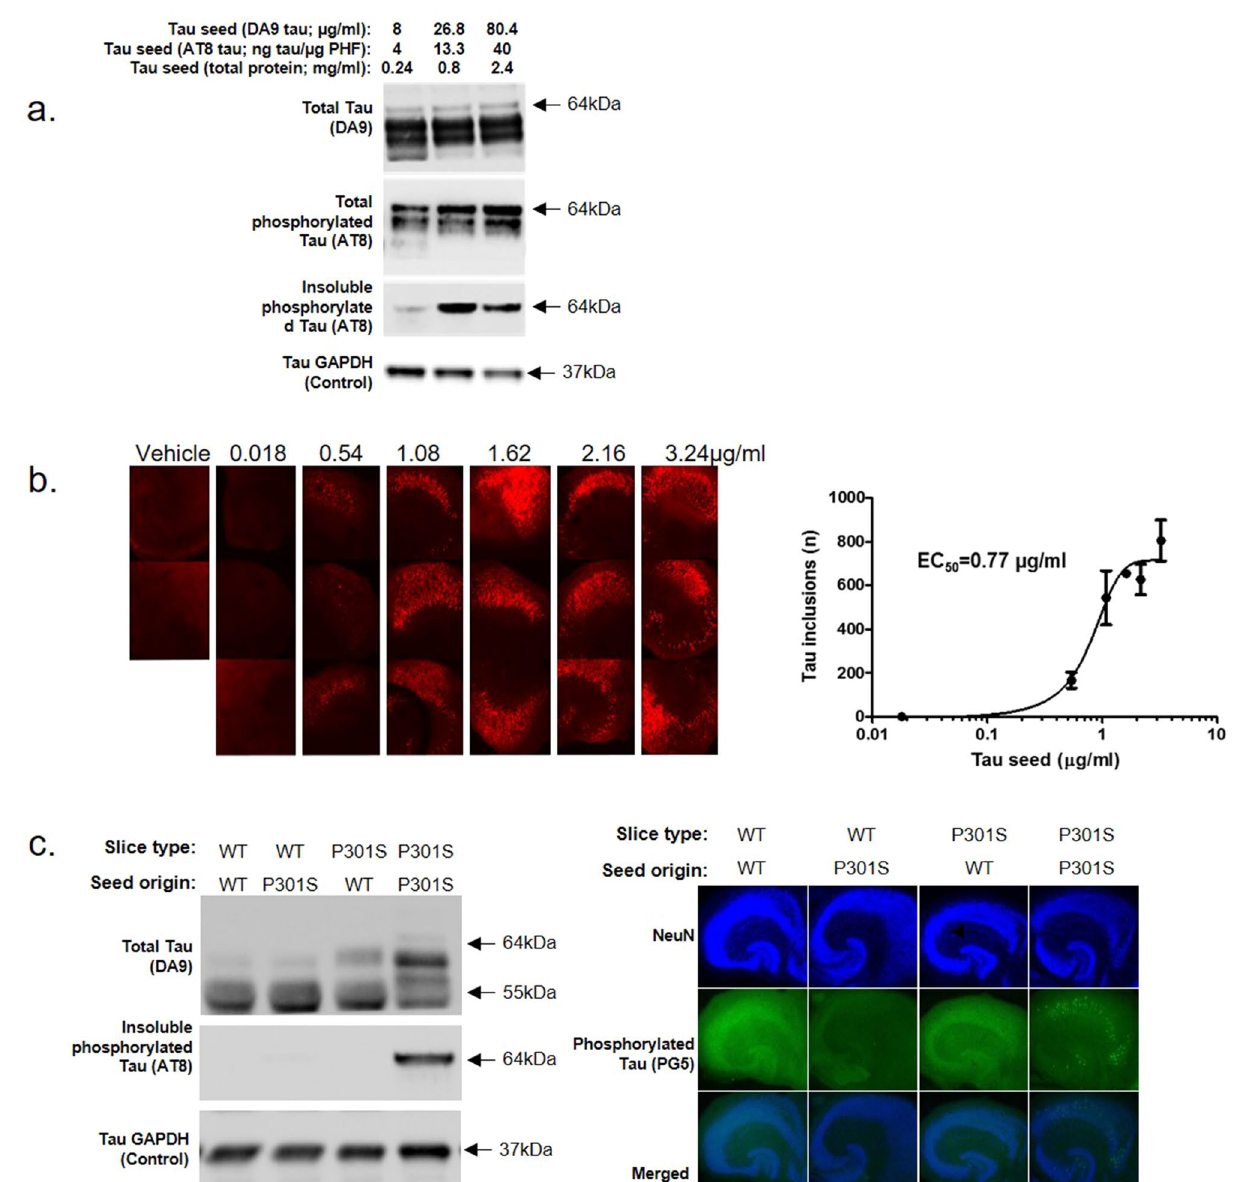
Figure 3. A robust and concentration dependent accumulation of insoluble phosphorylated tau in P301S OHCs seeded with P301S seed. ( a ) OHCs from P7 P301S mice were seeded immediately after preparation with various concentrations of brain homogenate from terminally ill P301S mice or aged matched WT mice. Slices were cultured for 2 weeks, lysed, fractionated and analyzed via immunoblot. Soluble or S1 fraction: Total tau (DA9), Total phosphorylated tau (AT8), GAPDH (Control). Insoluble pellet: phosphorylated tau (AT8). The maximum production of insoluble tau was seen with a seed comprising of 13.3 ng tau/µg PHF. Western blot image cropped for focus. For full original image see Supp Fig. 2. ( b ) These data could also be replicated using immunolabelling, where there was a visible increase in the number of MC1 positive tau inclusions with an increase in application of brain homogenate containing seed, an EC 50 value of 0.77 µg/ml could be obtained. ( c ) OHCs from P7 P301S and WT mice cultured for 1 week were, lysed, fractionated and analyzed via immunoblotting for insoluble phosphorylated tau or fixed and analyzed for PG5 + tau via IHC. Only P301S slices seeded with P301S brain homogenate produced a detectable level of insoluble and phosphorylated tau. Western blot image cropped for focus. For full original image see Supp Fig.